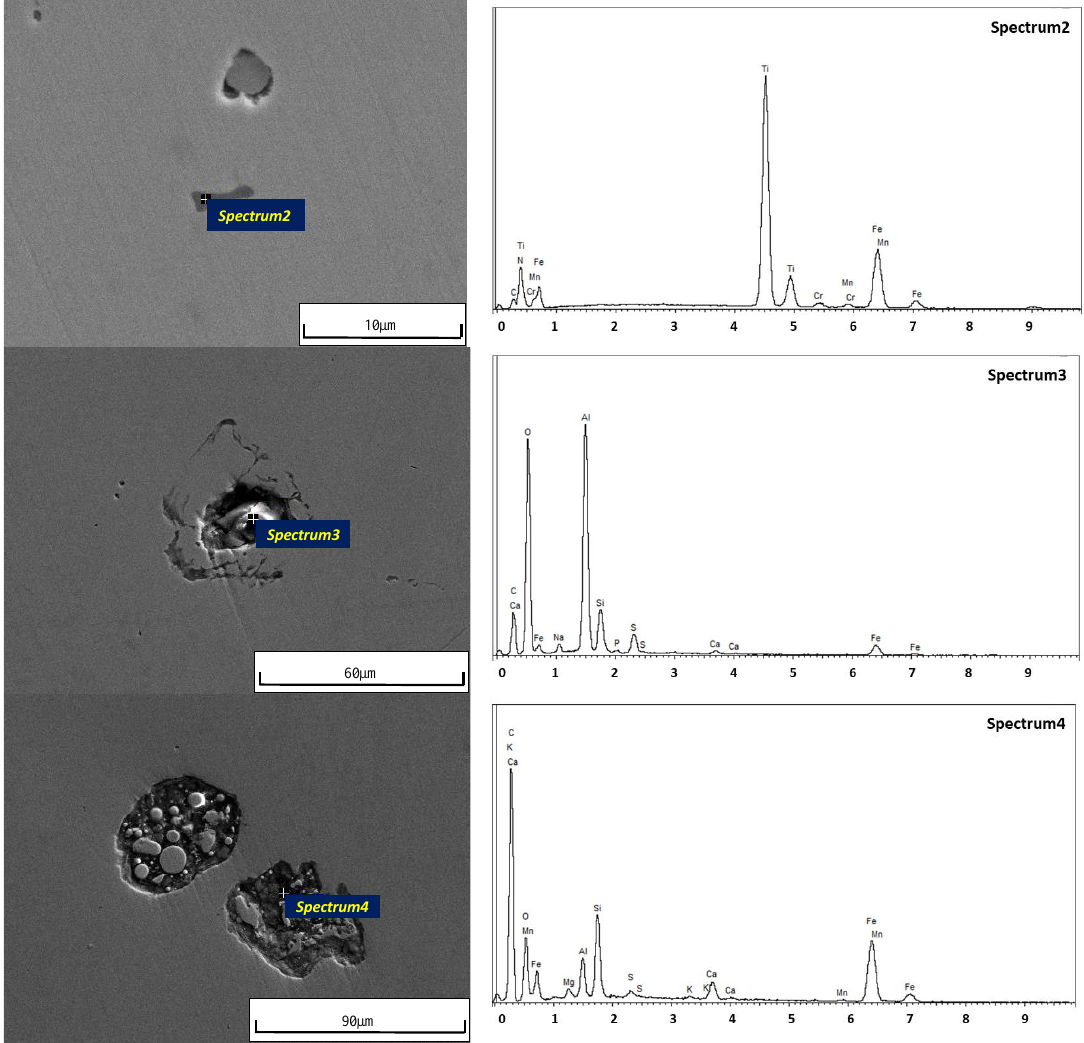
Figure 9. Morphology and composition of micro-inclusions in severe porosity steel.